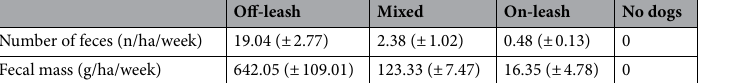
Off-leash Mixed On-leash No